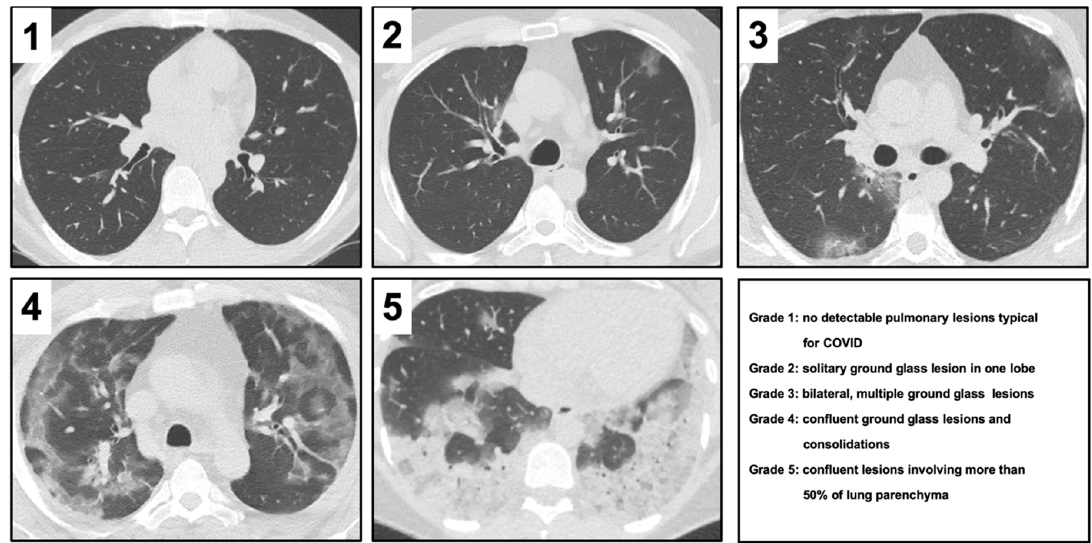
Figure 1. Images exemplifying the five radiological severity scores in computed tomography images alongside their descriptions. COVID, coronavirus disease.